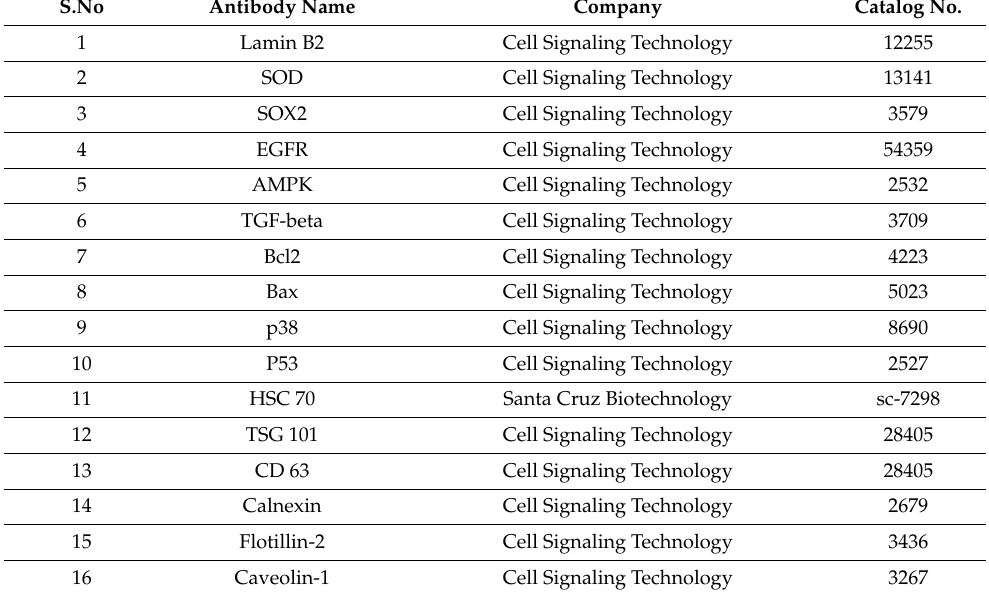
Table 2. Antibody